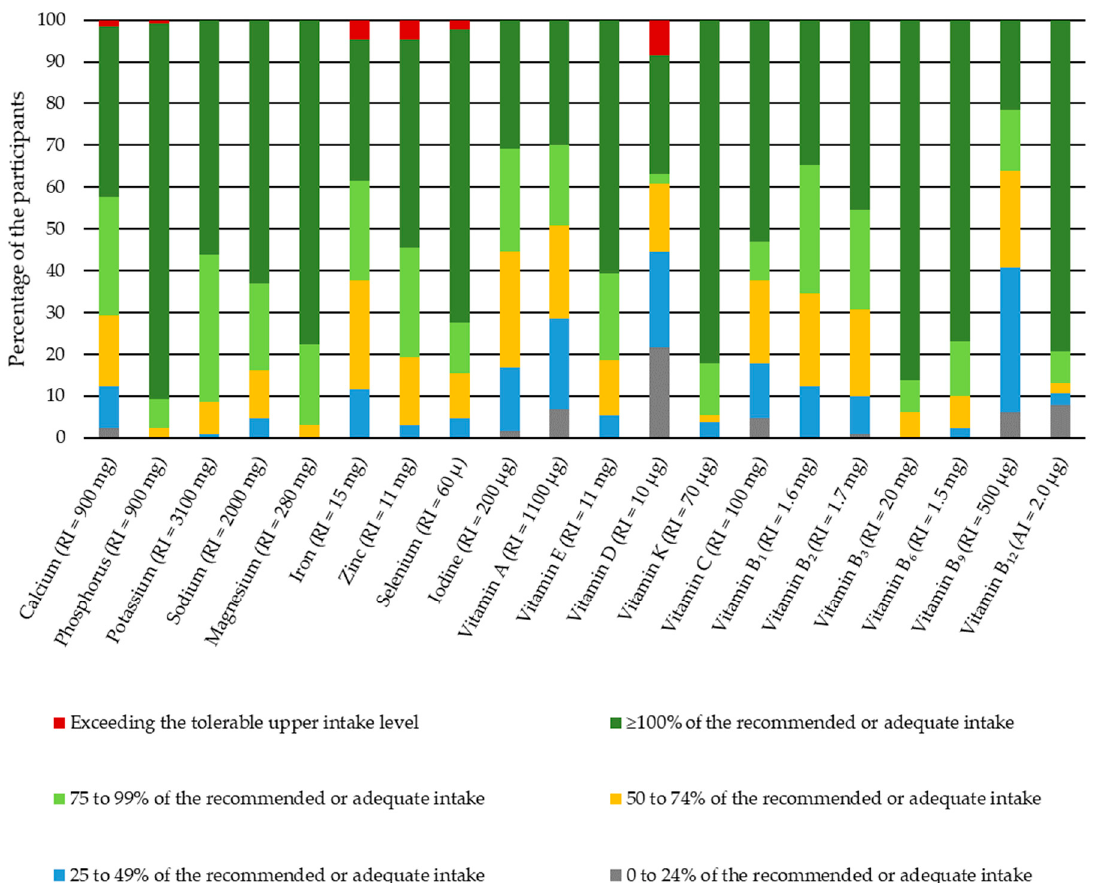
Figure 1. Median micronutrient intakes among the participants, percentage of the recommended intake or adequate intake n = 130.